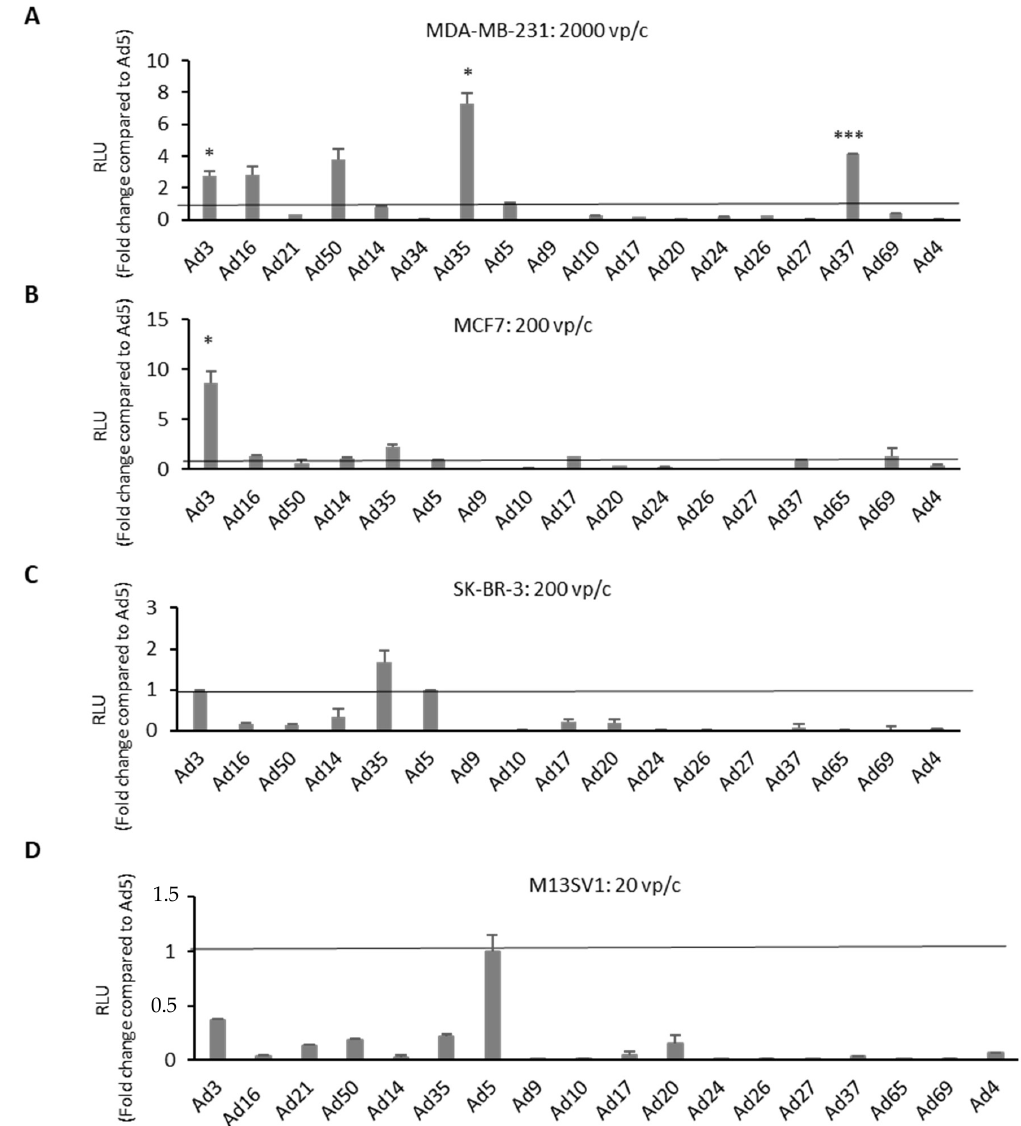
Figure 2. High-throughput screening of the reporter-tagged human adenovirus library in human BC-related cells. Transgene expression levels of di ff erent adenovirus types (Ad type number) were evaluated in BC-related cell lines. Cells were infected with each virus at various virus particle numbers per cell (vp / c). Shown are ( A ) MDA-MB-231 cells at 2000 vp / c, ( B ) MCF7 cells at 200 vp / c, ( C ) SK-BR-3 cells at 200 vp / c, and ( D ) breast epithelia cells M13SV1 infected with at 20 vp / c is used as control. Results from other vp / c are shown in the Figure S1. Luciferase expression levels were measured 24 h postinfection by addition of furimazine substrate and expressed as relative light units (RLU). Levels were compared to the commonly used adenovirus type 5 (Ad5) and indicated as fold change. Error bars, ± SEM of three independent experiments. * p < 0.05; *** p < 0.001; compared to Ad5